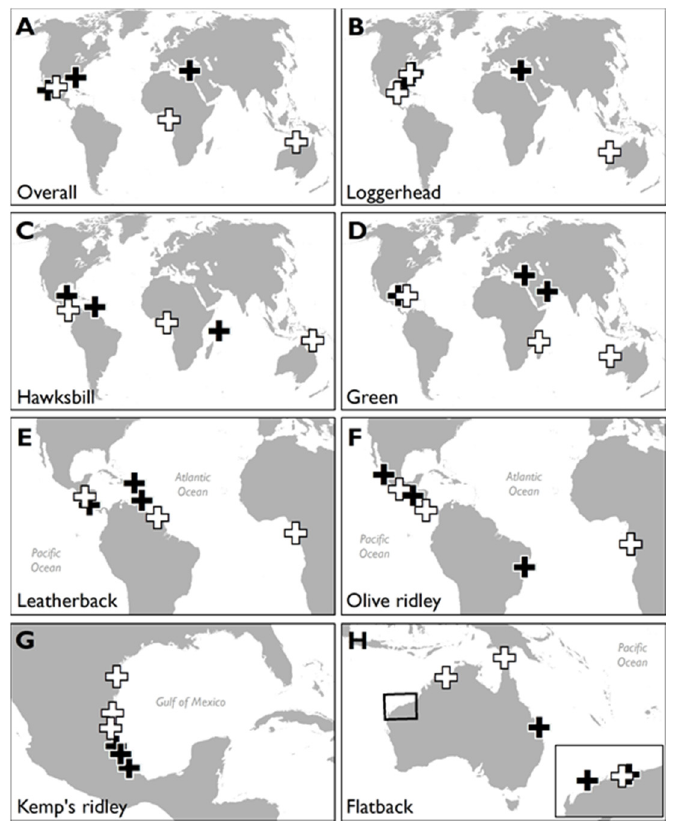
Figure 3. Maps showing the locations of marine turtle rookeries with the most (n = 3 numbered black crosses per map, where numbers indicate rank position) and least (n = 3 numbered white crosses per map) HACD: for ( A ) all turtles, ( B ) loggerhead turtles, ( C ) hawksbill turtles, ( D ) green turtles, ( E ) leatherback turtles, ( F ) olive ridley turtles, ( G ) Kemp’s ridley turtles, and ( H ) flatback turtles. Maps shown to different scales.